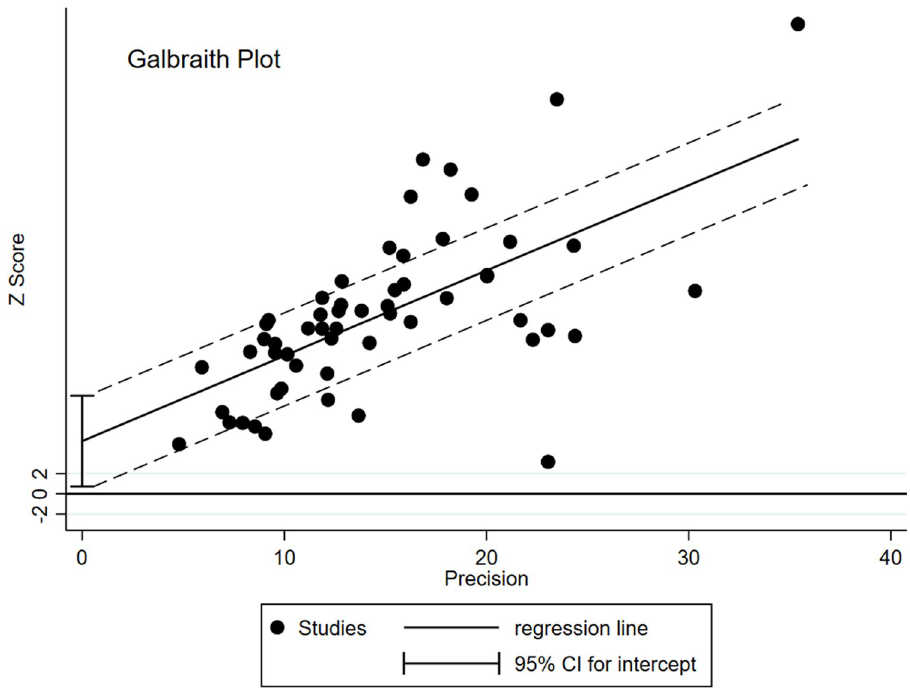
Fig 4. Galbraith plot analysis of all the included